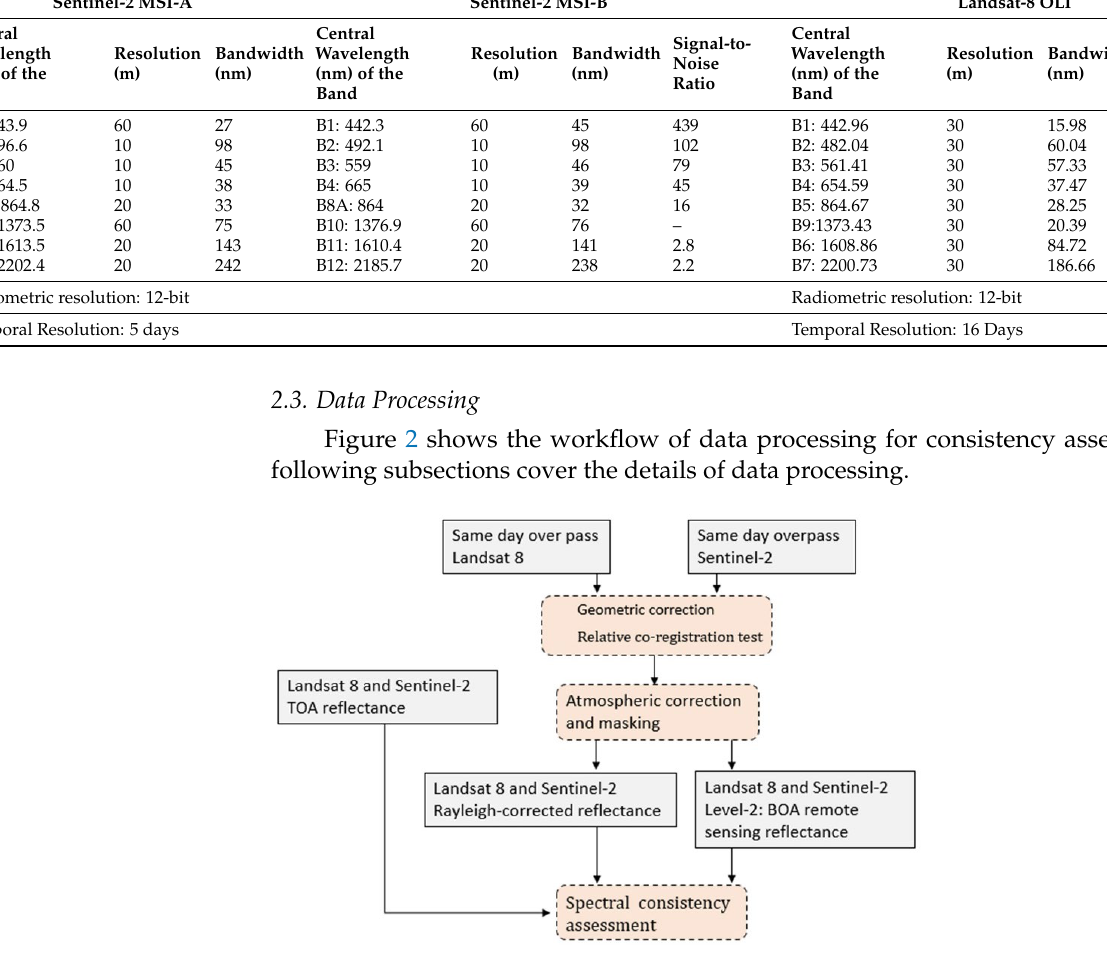
Figure 2 . Workflow for spectral consistency assessment of Landsat-8 and Sentinel-2 . Figure 2. Workflow for spectral consistency assessment of Landsat-8 and